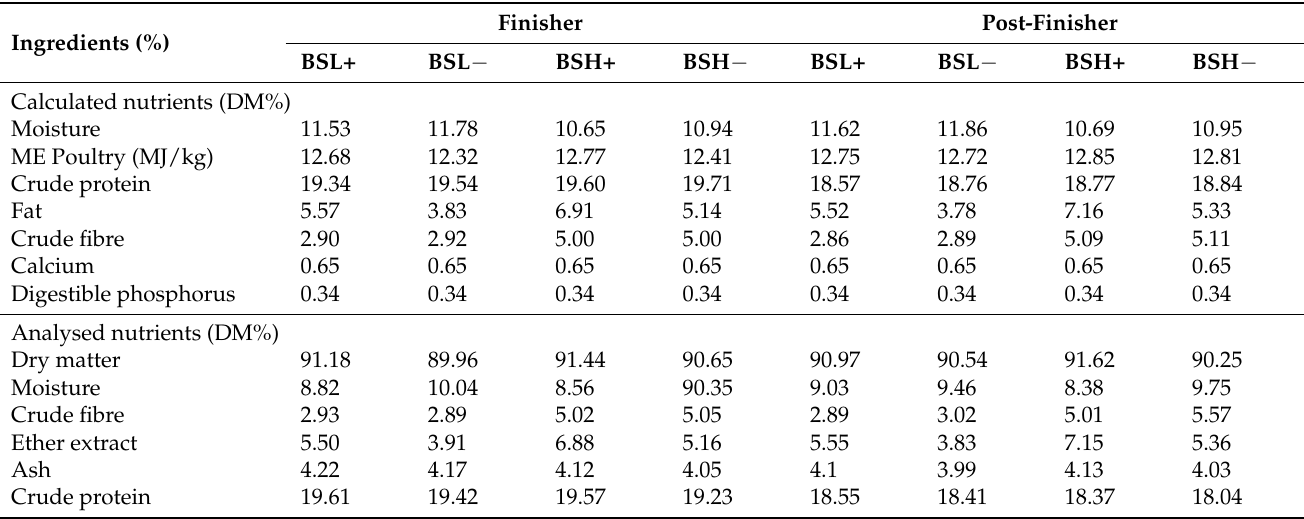
Table 4. Calculated and analysed basal dietary treatments formulations used in the experiment (finisher and